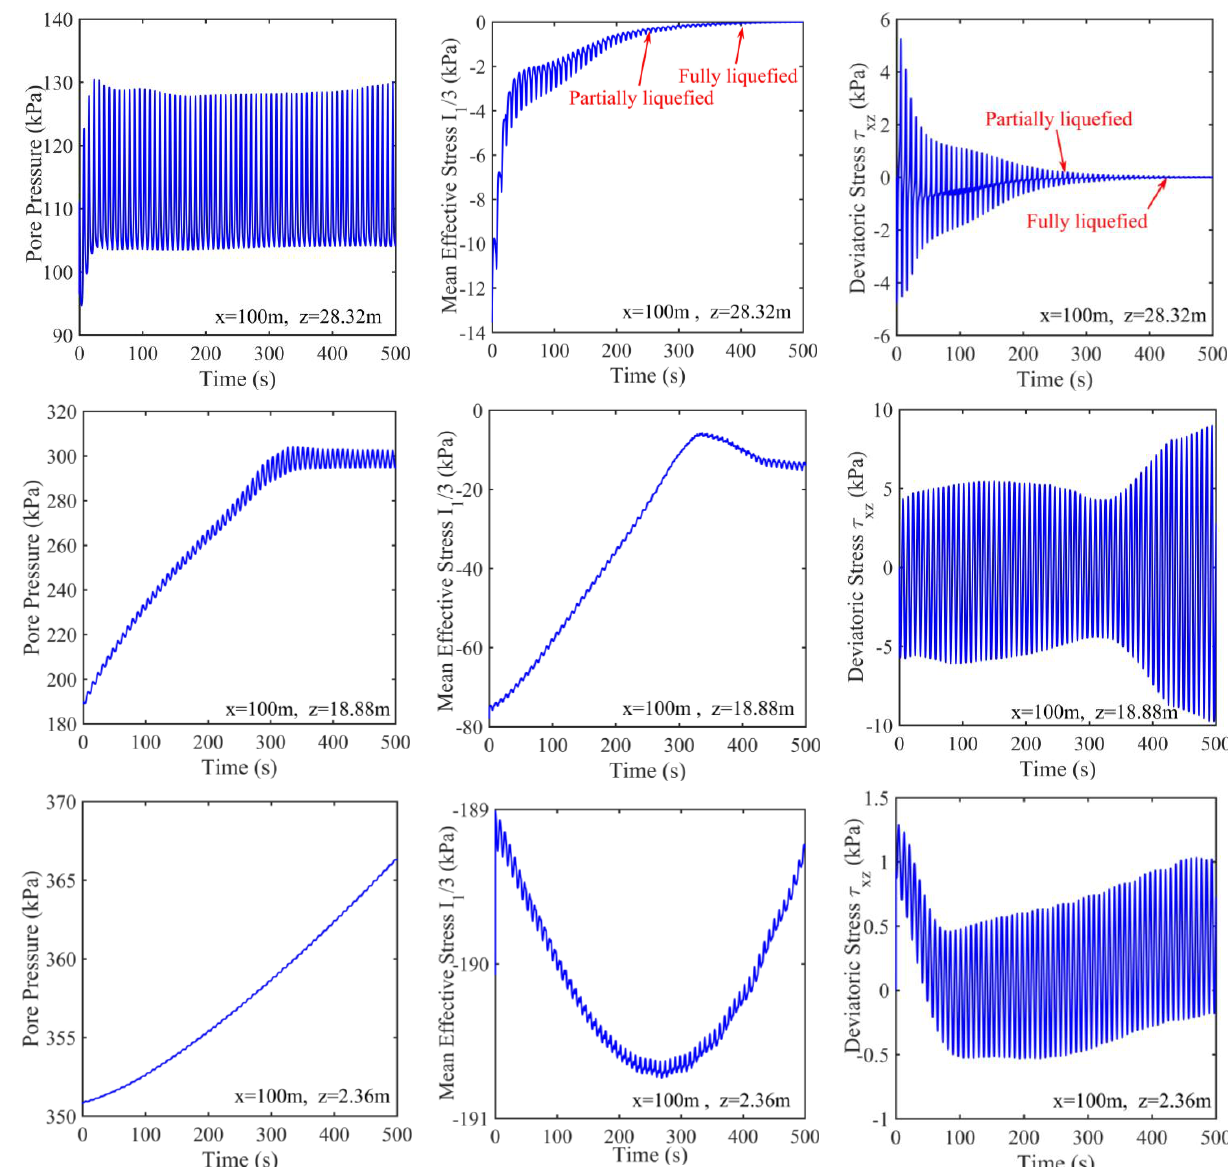
Figure 4. Time histories of the pore pressure, mean effective stress I 1 /3, and shear stress at three typical buried depths (note: compression is taken as negative).